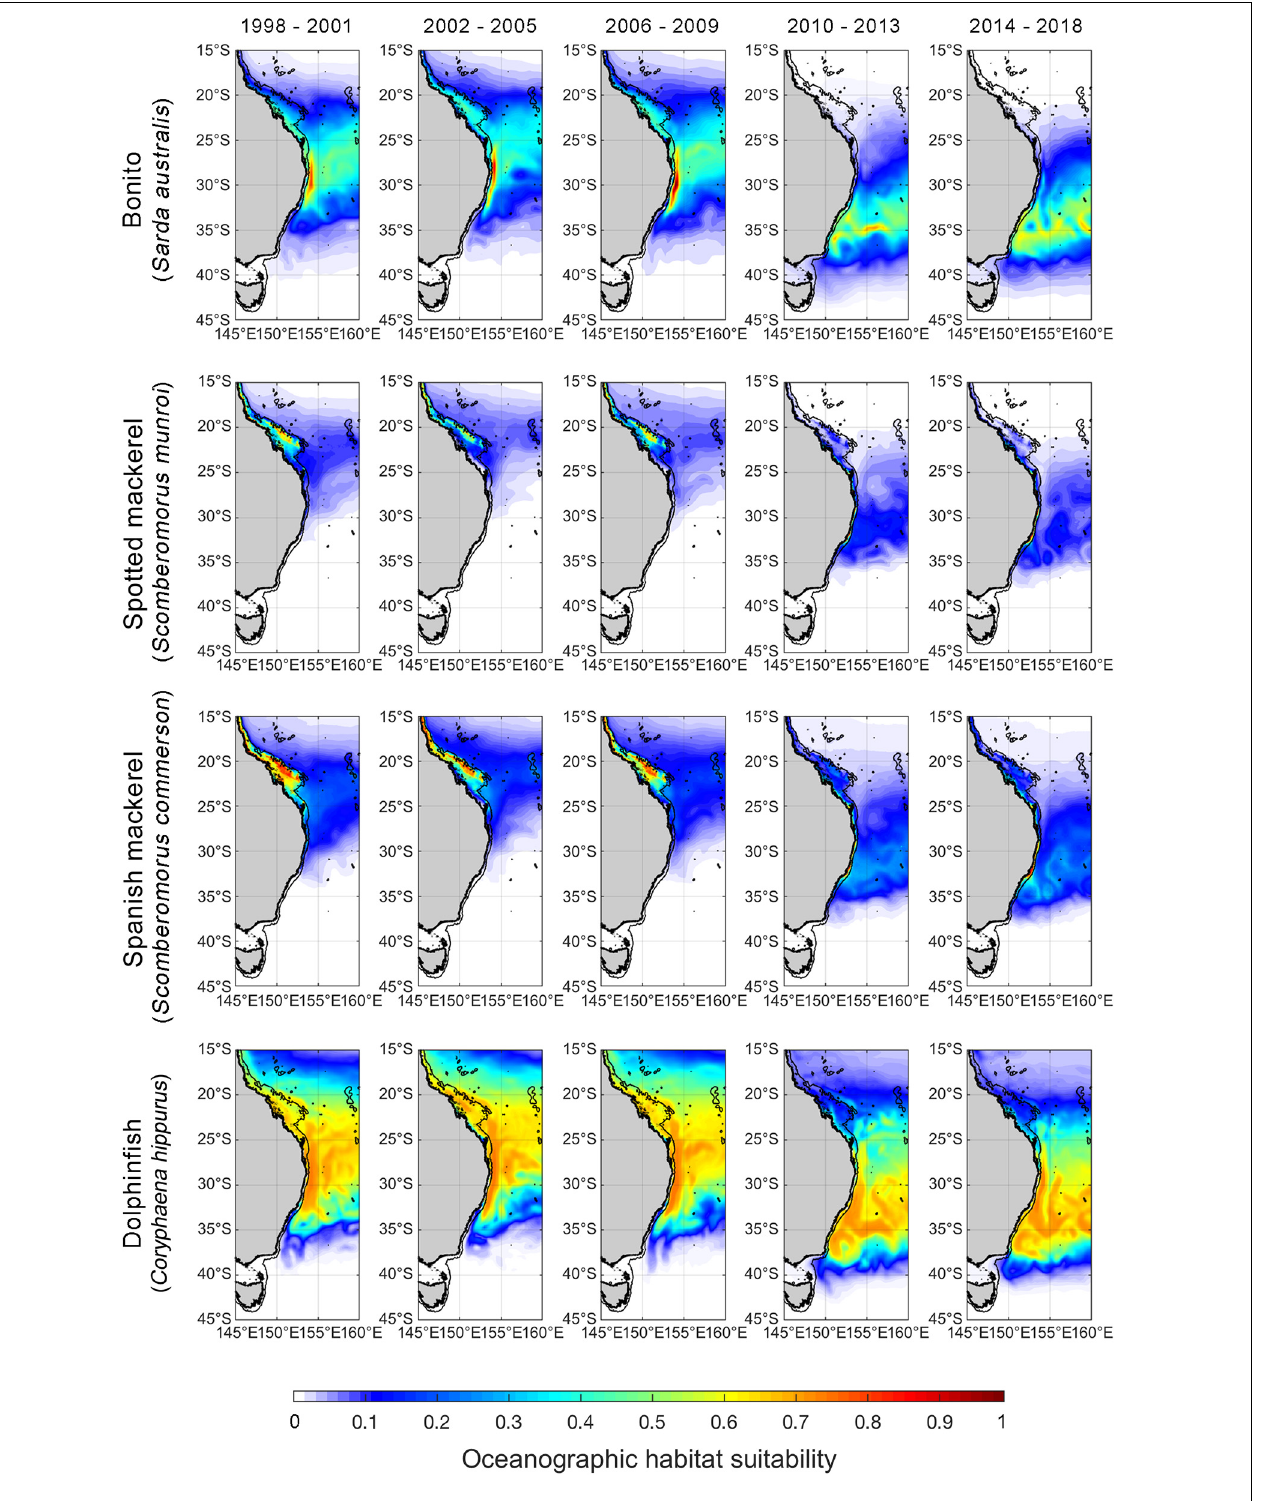
FIGURE 4 | Spatial predictions of Autumn oceanographic habitat suitability off eastern Australia from January 1998 to December 2018. Monthly predictions have been averaged into 4-year time bins to aid visualisation of temporal trends. The black line offshore of the coastline denotes the continental shelf-break (i.e., 200-m isobath). We note that although spatial predictions of oceanographic habitat have been extrapolated beyond the continental shelf-break to improve visual communication in this figure, range shift analyses were only undertaken on oceanographic habitat nearshore of the continental shelf boundary.